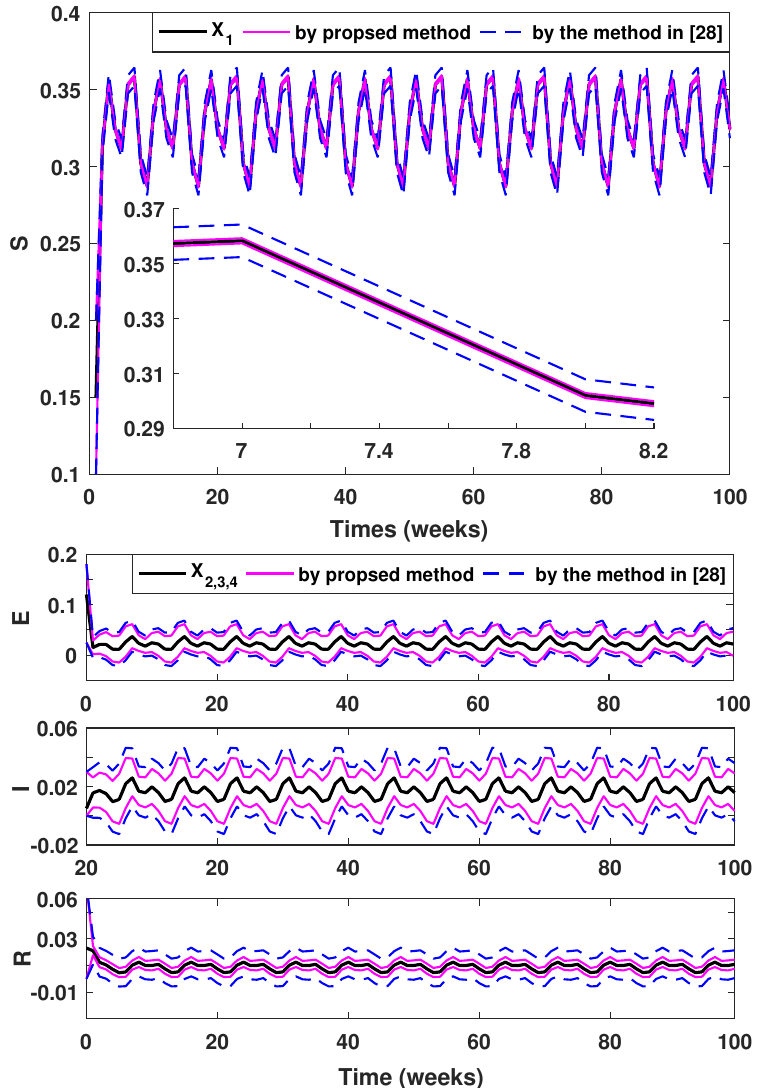
Figure 2. Interval estimations by proposed method vs. given in [28] for each state variable x 1 , x 2 , x 3 , x 4 corresponding to S , E , I , R